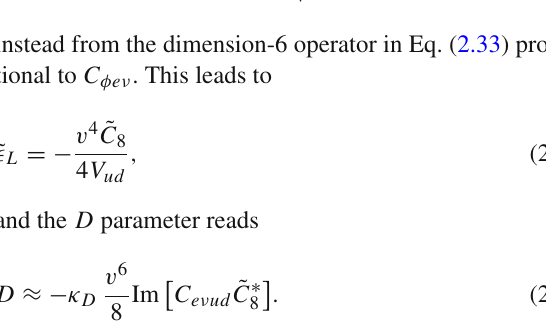
EFT expansion parameter (cid:16) at which the D parameter appears. Finally, we give an estimate of the maximum magnitude of the BSM D param- eter in each scenario based on purely EFT and naturalness arguments